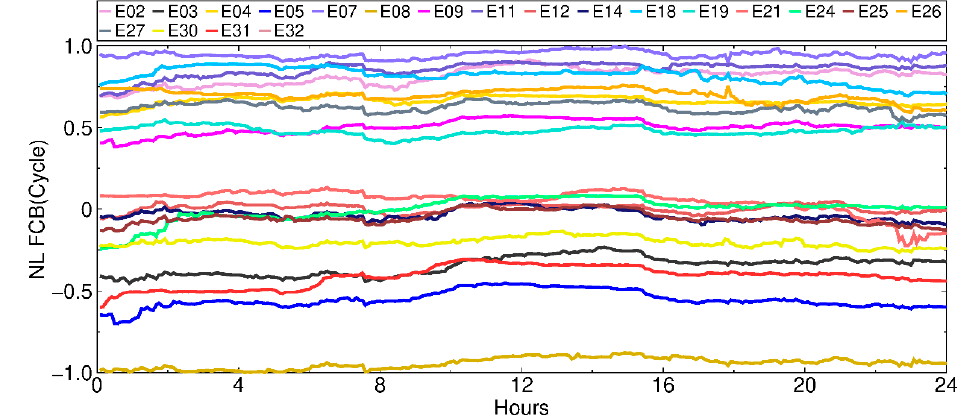
Figure 5. Galileo NL FCB on DOY 328, 2018, referenced to E01.